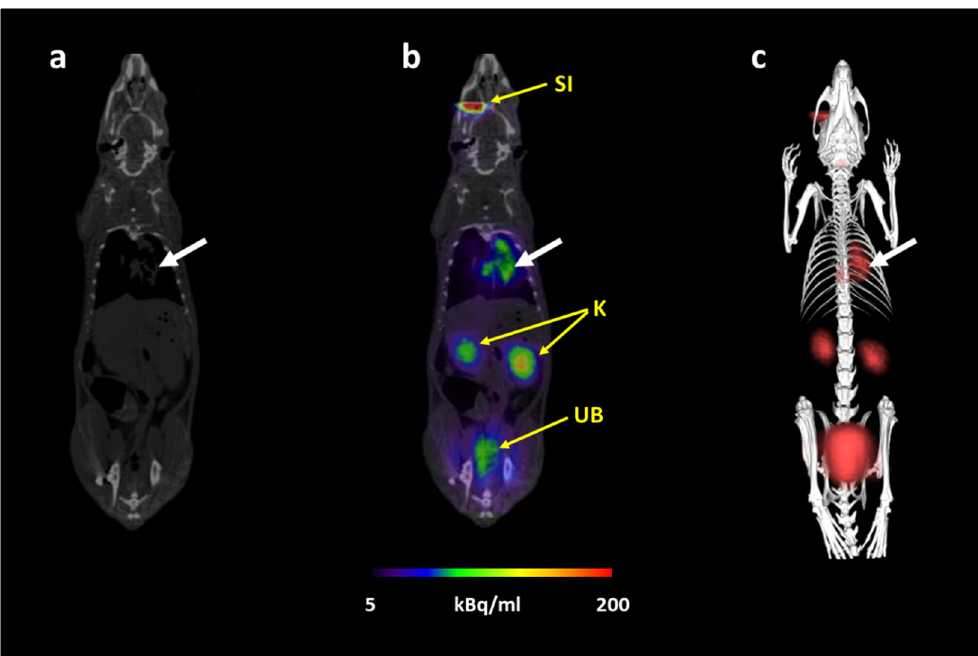
Figure 2. Static PET/CT images of [ 68 Ga]Ga-DFO-B in pulmonary A. fumigatus -infected Lewis rats 45 min after injection: ( a ) CT coronal slice, ( b ) fused PET/CT coronal slice and ( c ) 3D volume rendered PET/CT image. White arrow indicates A. fumigatus infection, SI = site of injection, K = kidneys, UB = urinary bladder.